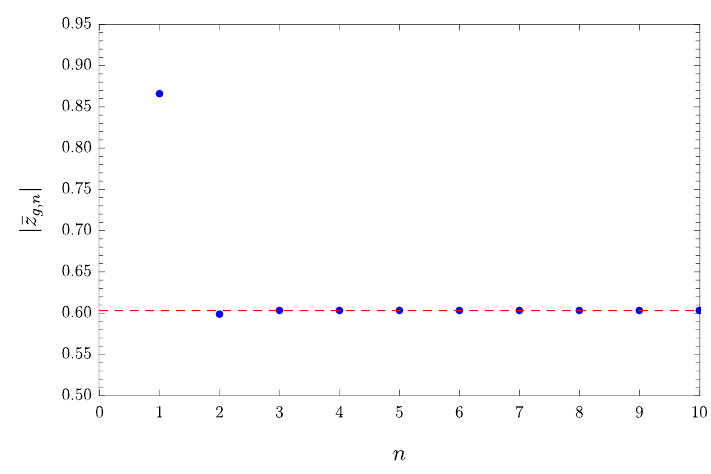
Figure 11 . A plot showing the rapid convergence of the Newton-Raphson expression in eq. (A.3) for | ¯ z g | in the N = 4 SYM theory plotted for orders n = { 1 , . . . , 10 } . The red dashed line